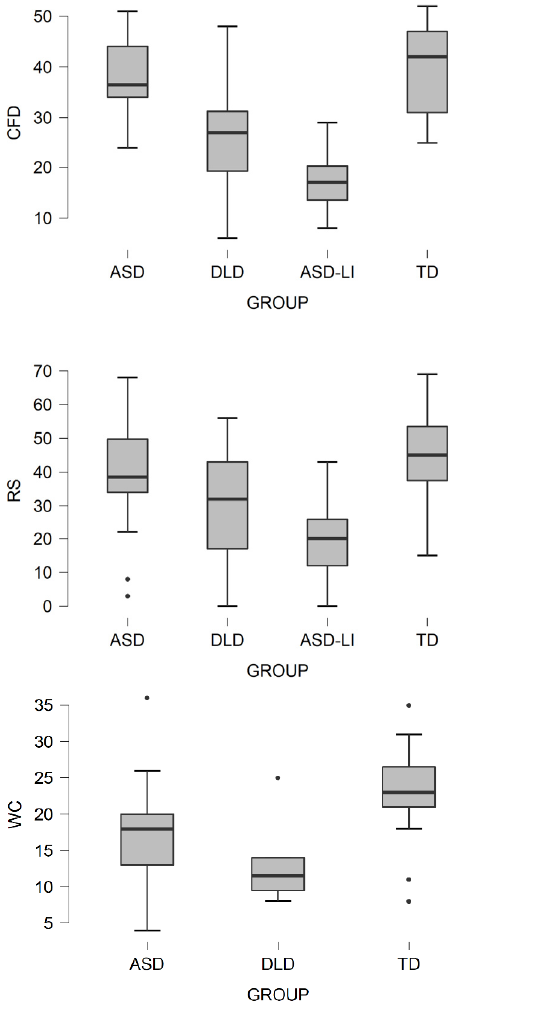
Figure 3. Boxplots for all language measures. CFD = Concept and following directions; WS = Word structure; RS = Recalling sentences; FS = Formulated sentences, WC = Word classes; NWR = Non-word repetition task. Table 4. Intra-class correlation and confidence intervals (CI) for Language Measures and CCC-2 Composites.